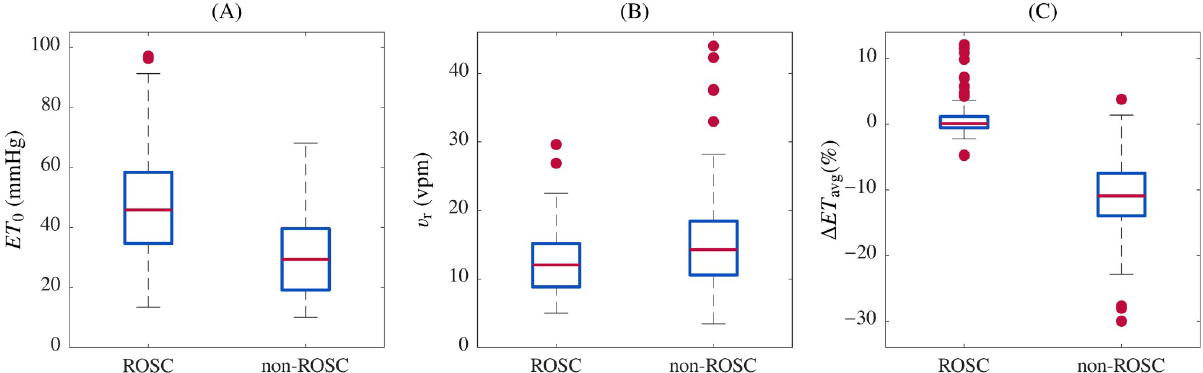
Fig 4. Statistical distributions for ROSC and non-ROSC segments. Initial ETCO 2 ( ET 0 ), ventilation rate ( v r ), and average variation ( Δ ET avg ) for all ROSC and non-ROSC segments included in the study.